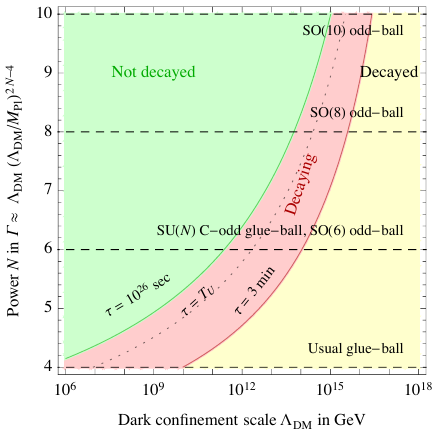
Figure 2 . Estimated lifetime of glueballs, compared to time-scales relevant for indirect detection bounds and Big Bang